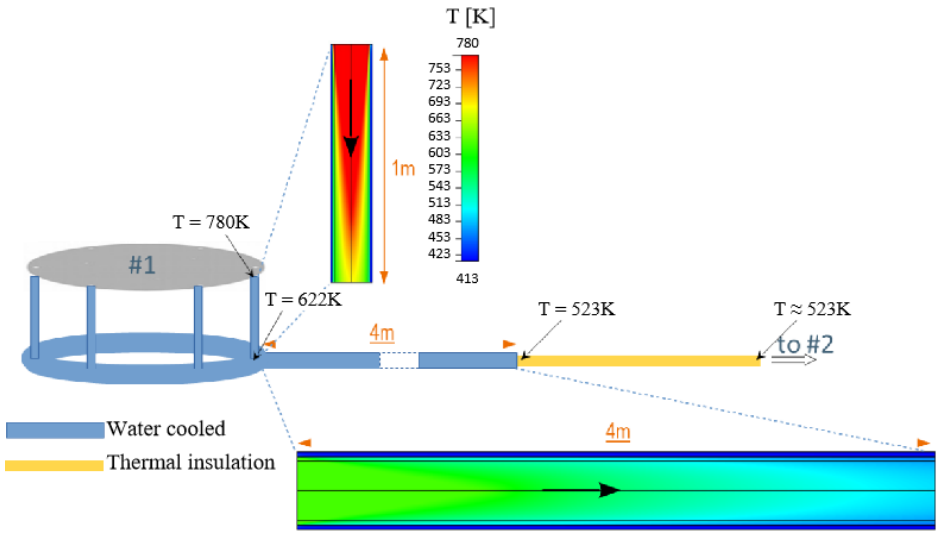
Figure 8. Temperature distribution of tail gas.